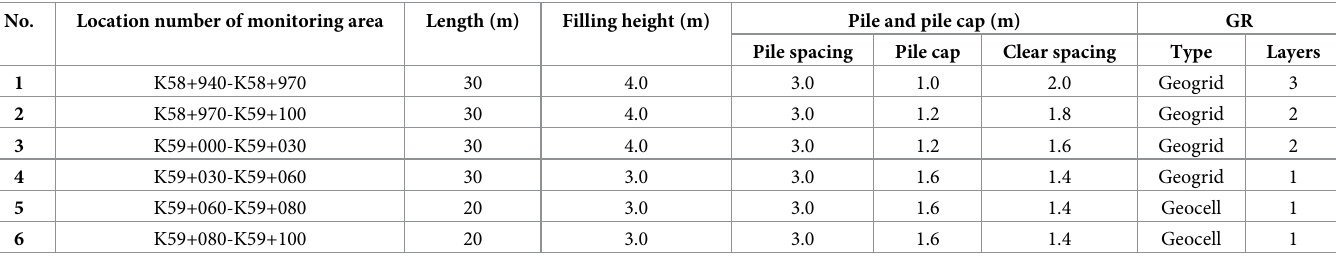
Table 2. Monitoring design parameters for each monitoring